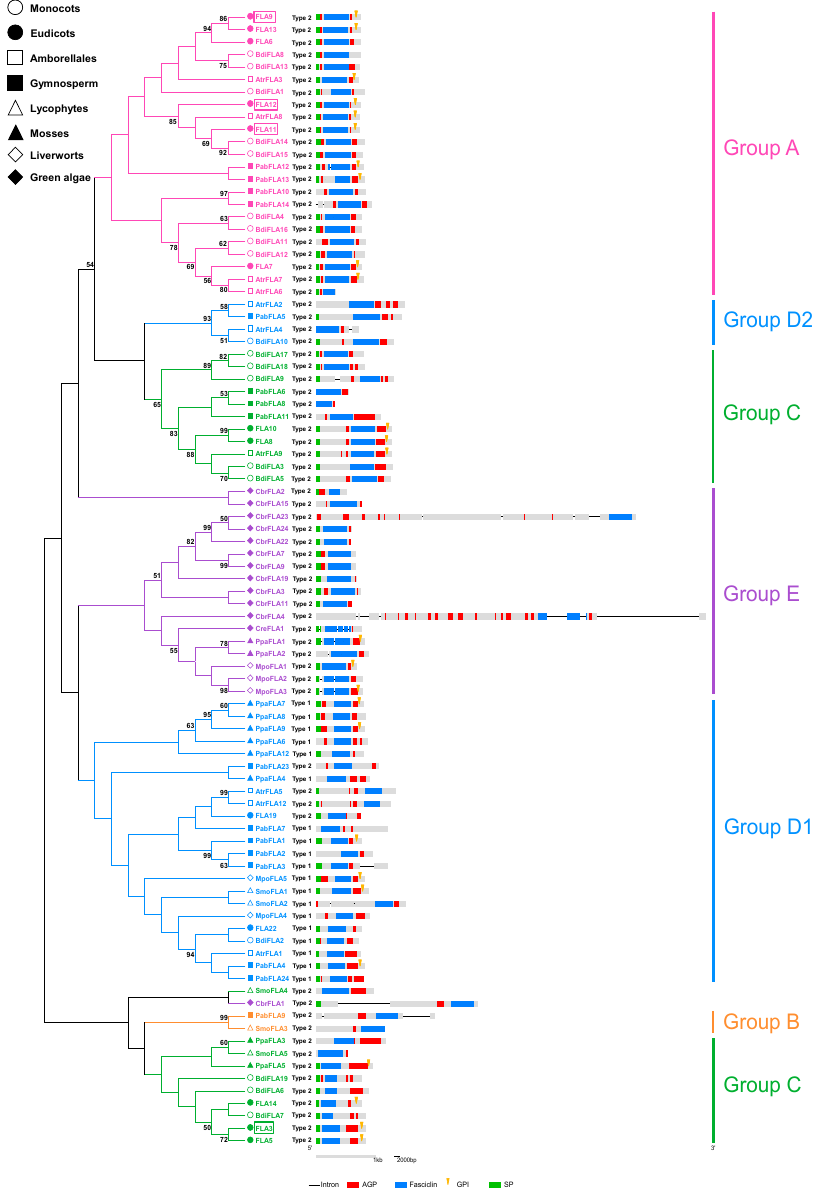
Figure 4. Phylogenetic relationships and structure display of FLAs with single fasciclin domain in nine plant species ( C. reinhardtii , C. crispus , M. polymorpha , P. patens , S. moellendorffii , P. abies , A. trichopoda , B. distachyon , and A. thaliana ). Plant species from different lineages are shown in different shapes. The phylogenetic trees were built by Mega 7 using the Maximum Likelihood (ML) method under LG + G model with 85% partial deletion. Bootstrap analyses with 1000 replicates were performed for support estimation, the confidence values higher than 50% are shown on nodes. The tree was divided into six groups according to the classifications based on two types fasciclin domains (Figures 2 and 3): Group A, Group B, Group C, Group D1, Group D2 and Group E. The structure displays were generated by GSDS 2.0. Black lines represent introns, gray rectangles the CDS regions, red rectangles the AGP regions, blue rectangles the fasciclin domains, green rectangles signal peptides, and yellow wedges GPI-anchor modification sites. The framed FLAs denote functionally characterized FLAs (FLA3, FLA9, FLA11, and